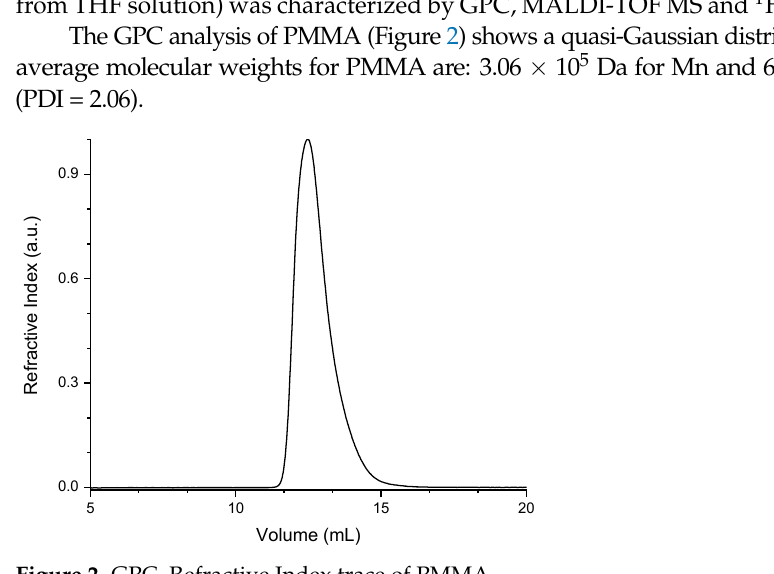
Figure 2. GPC, Refractive Index trace of PMMA.